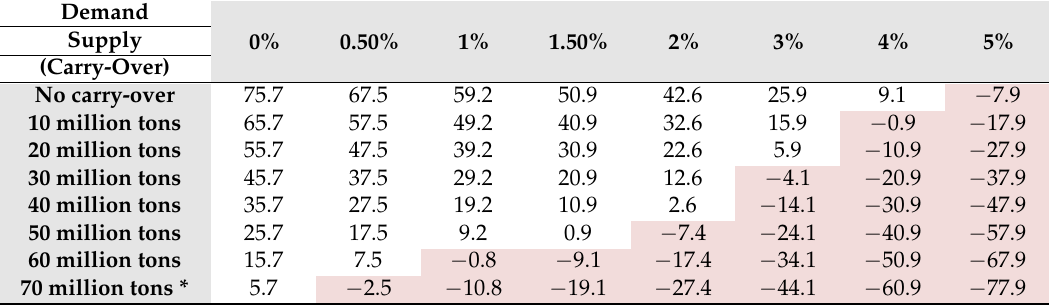
Table 6. Supply and demand comparison in the first phase: minimum level by demand growth rate in millions of tons. Demand (Carry-Over) No